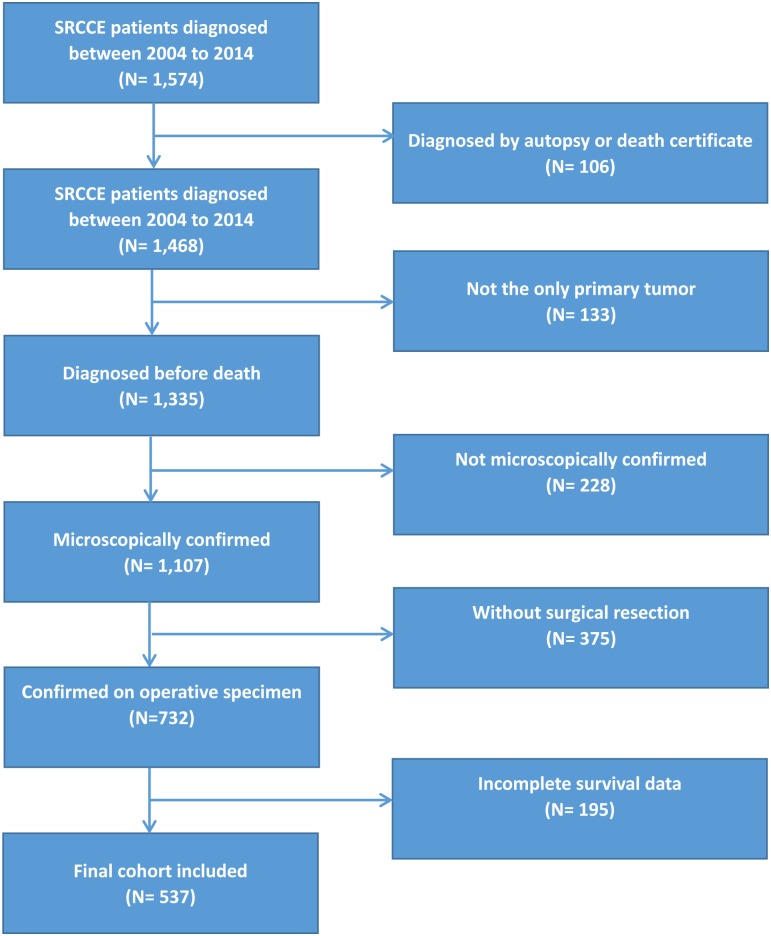
Flow chart for selection of the study cohort.